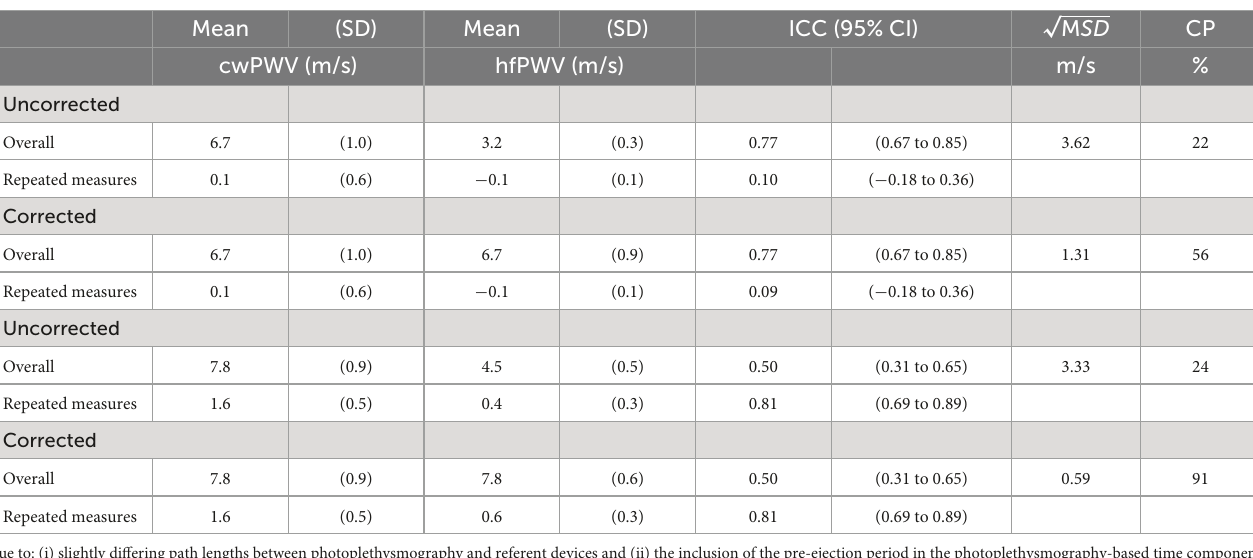
TABLE 3 Measurement agreement parameters including uncorrected and corrected results (Total data points =